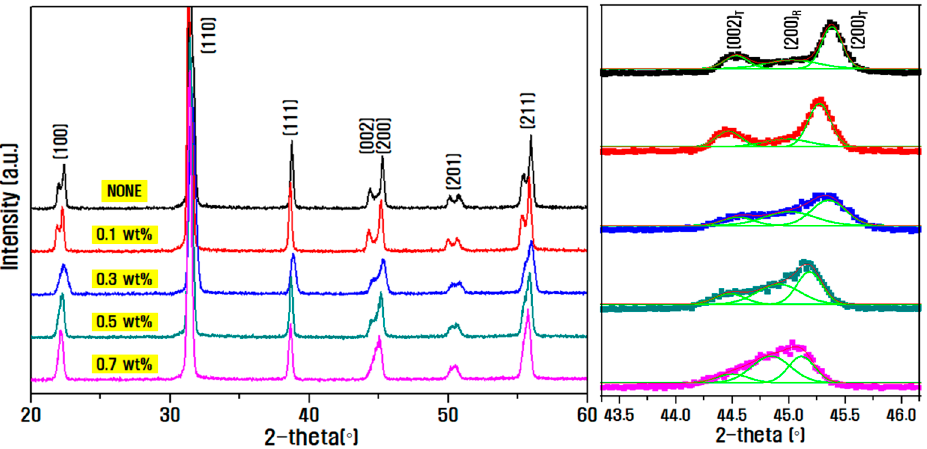
Figure 4. X-ray diffraction pattern analysis results according to the Sb 2 O 3 doping amount in PZN- PMN-PZT